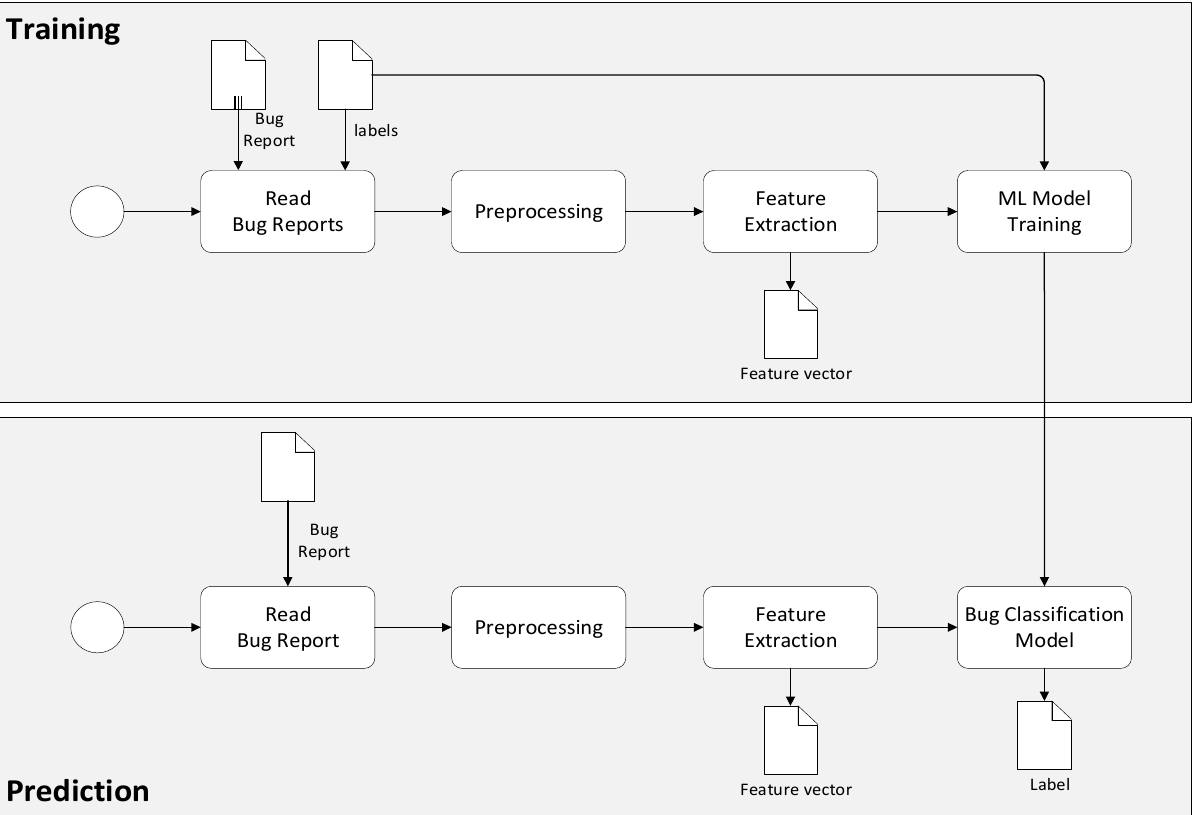
Figure 2. Machine learning ‐ based bug classification process.